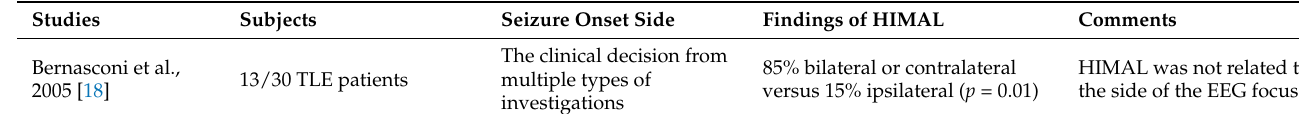
Table 2. Relationship between sides of seizure onset and